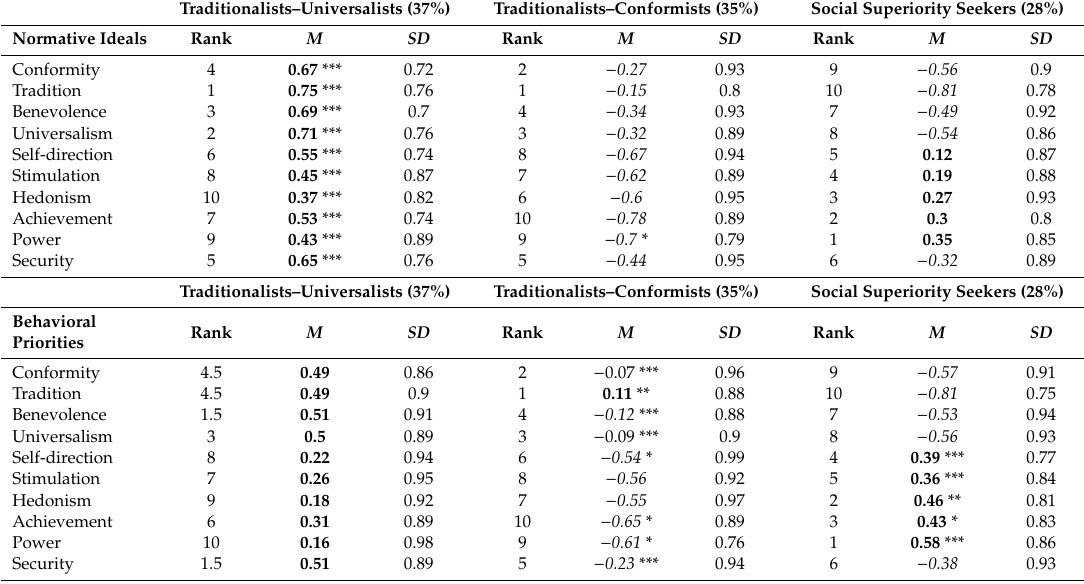
Table 1. Cluster Descriptive